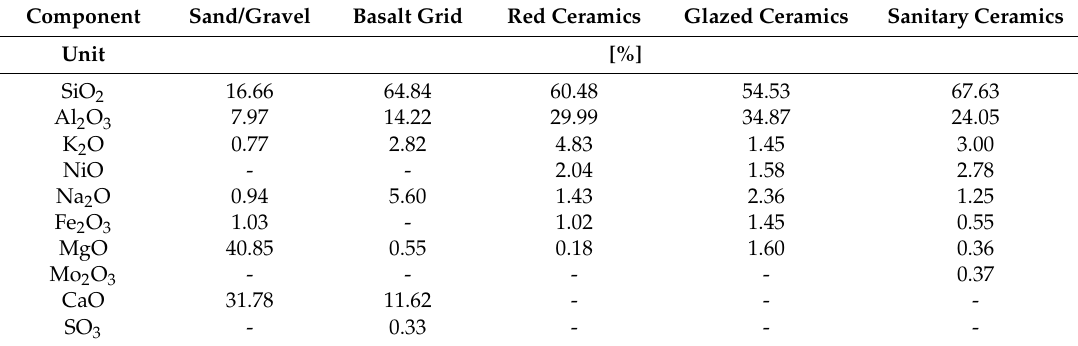
Table 1. The chemical composition of the aggregates used in the investigation. Component Sand/Gravel Basalt